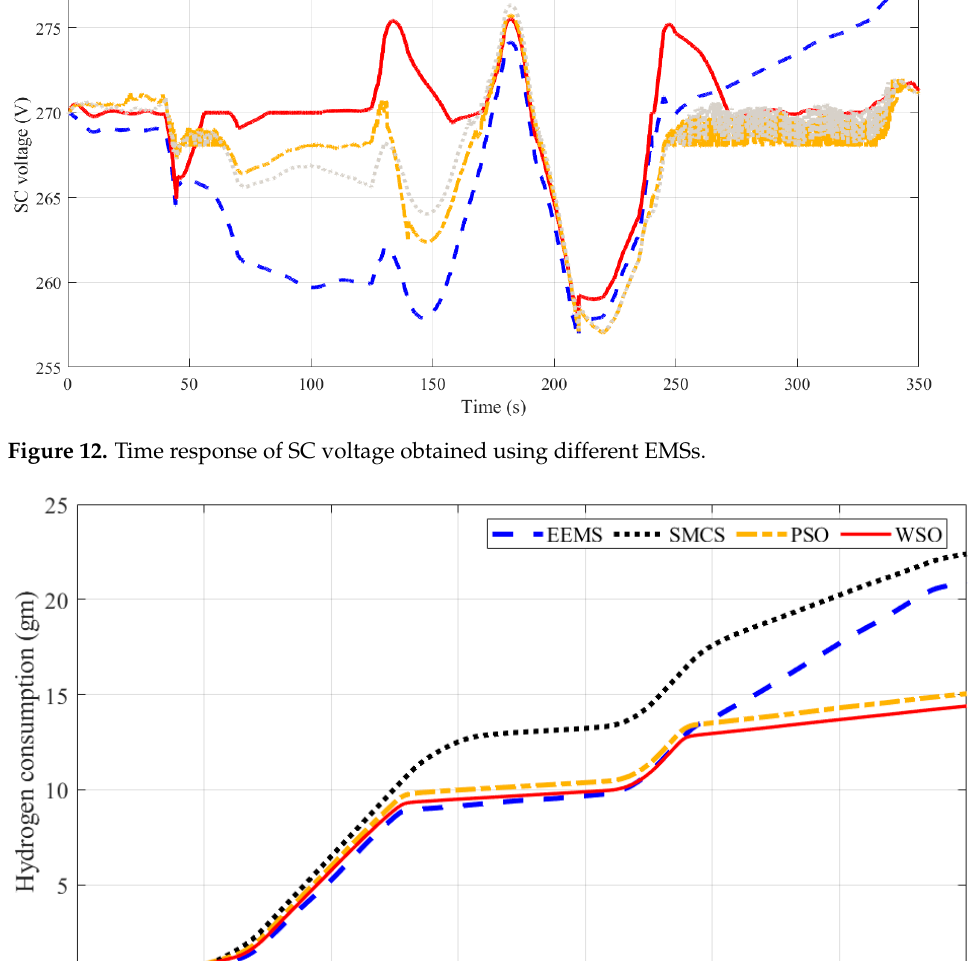
Table 4. Performance of the planned EMS-PPA in comparison to alternative methods.